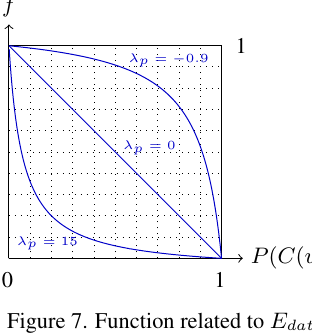
Figure 7. Function related to E data